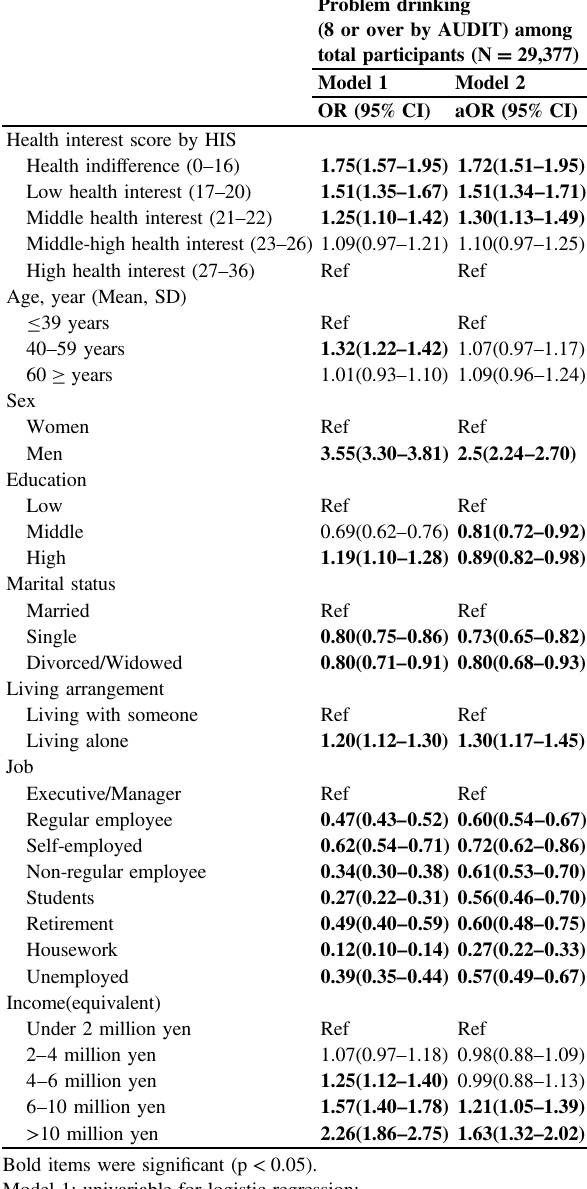
Table 3 Odds ratios of problem drinking according to health interest scale (HIS)